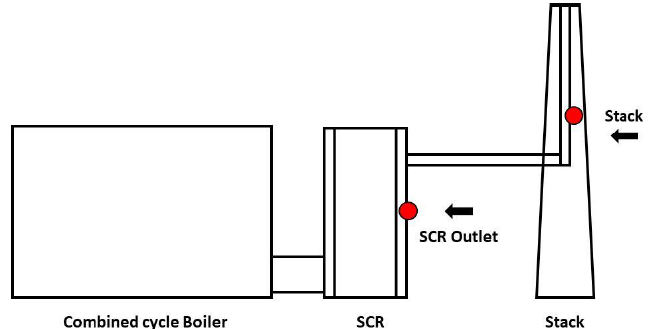
Figure 1. Schematic of the sampling point and air pollution prevention at Liquefied Natural Gas (LNG) power plants. power